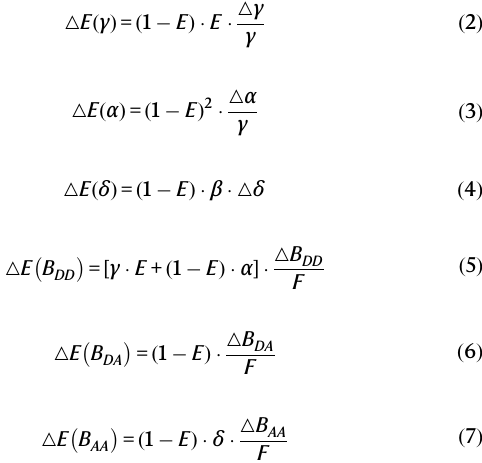
Table 7. Following 63 , we used relative errors of 10% for α , β , and γ . For the mean photon number per burst F , we used 75 and an error in the background counts of 1 photon ( Δ B DD , Δ B DA , and Δ B AA , for donor, FRET, and acceptor channel, respectively). The resulting error Δ E depends on the measured FRET ef fi ciency and ranges from 0.01 to 0.03fortherelevantrangeofFRETef fi ciencies,soweused Δ E =0.03as the upper